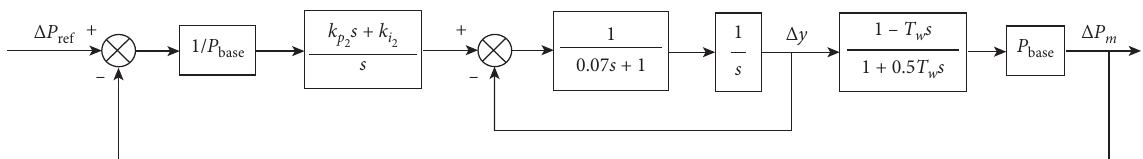
Figure 23: Control block diagram of the mechanical power control